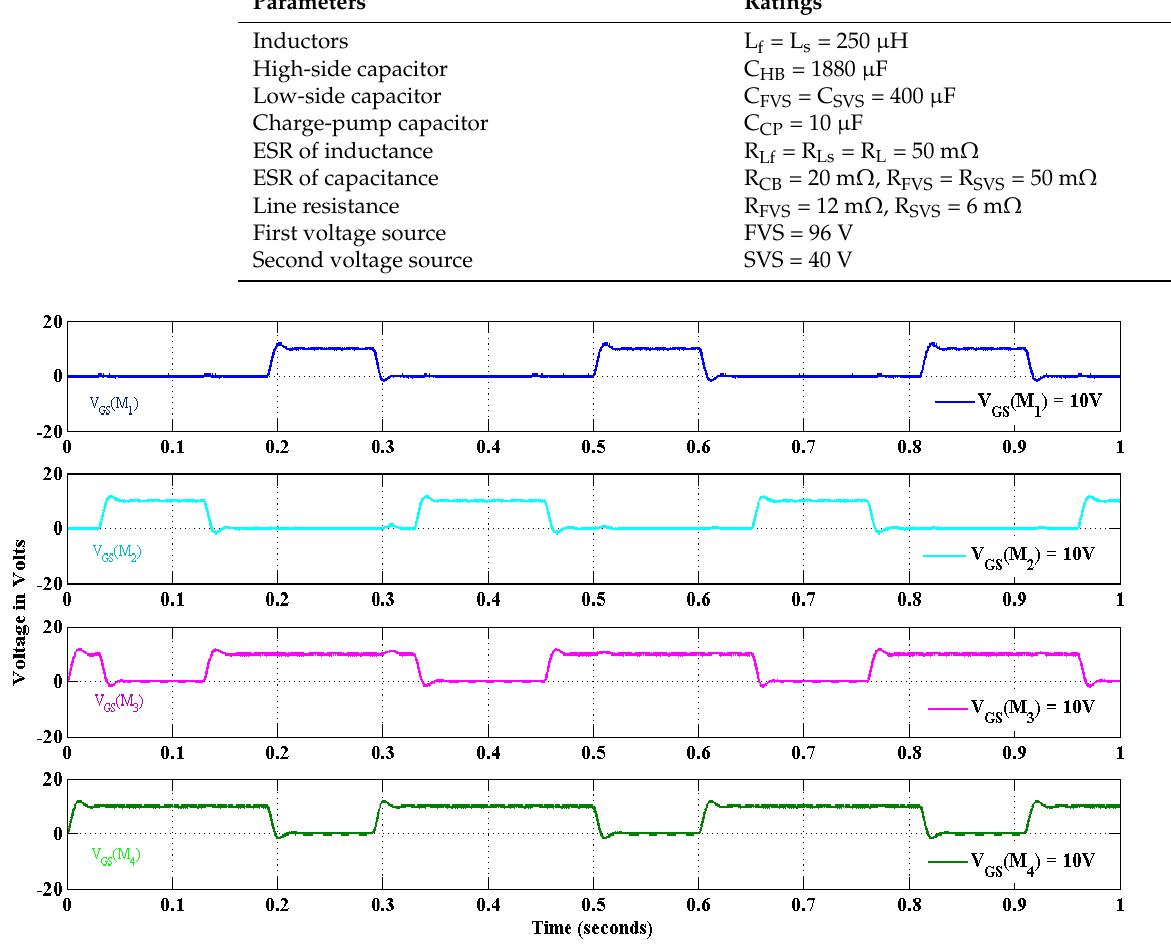
Figure 13. Gate signals in powering mode.